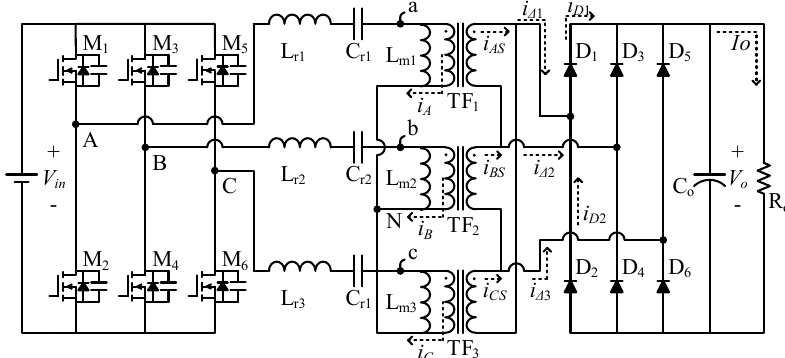
Figure 1. Topology of three-phase wye–delta